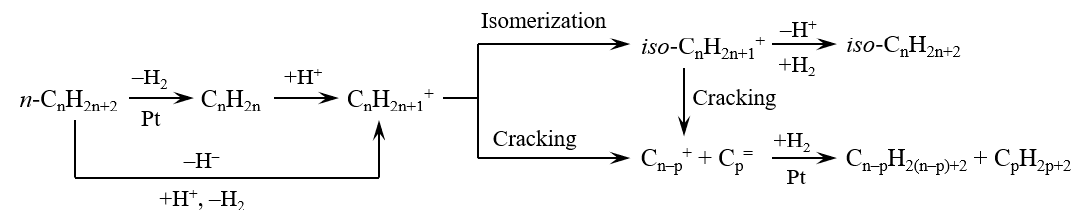
Figure 7. Reaction pathways in the hydrocracking of long-chain hydrocarbons over catalysts containing Pt and solid acids.